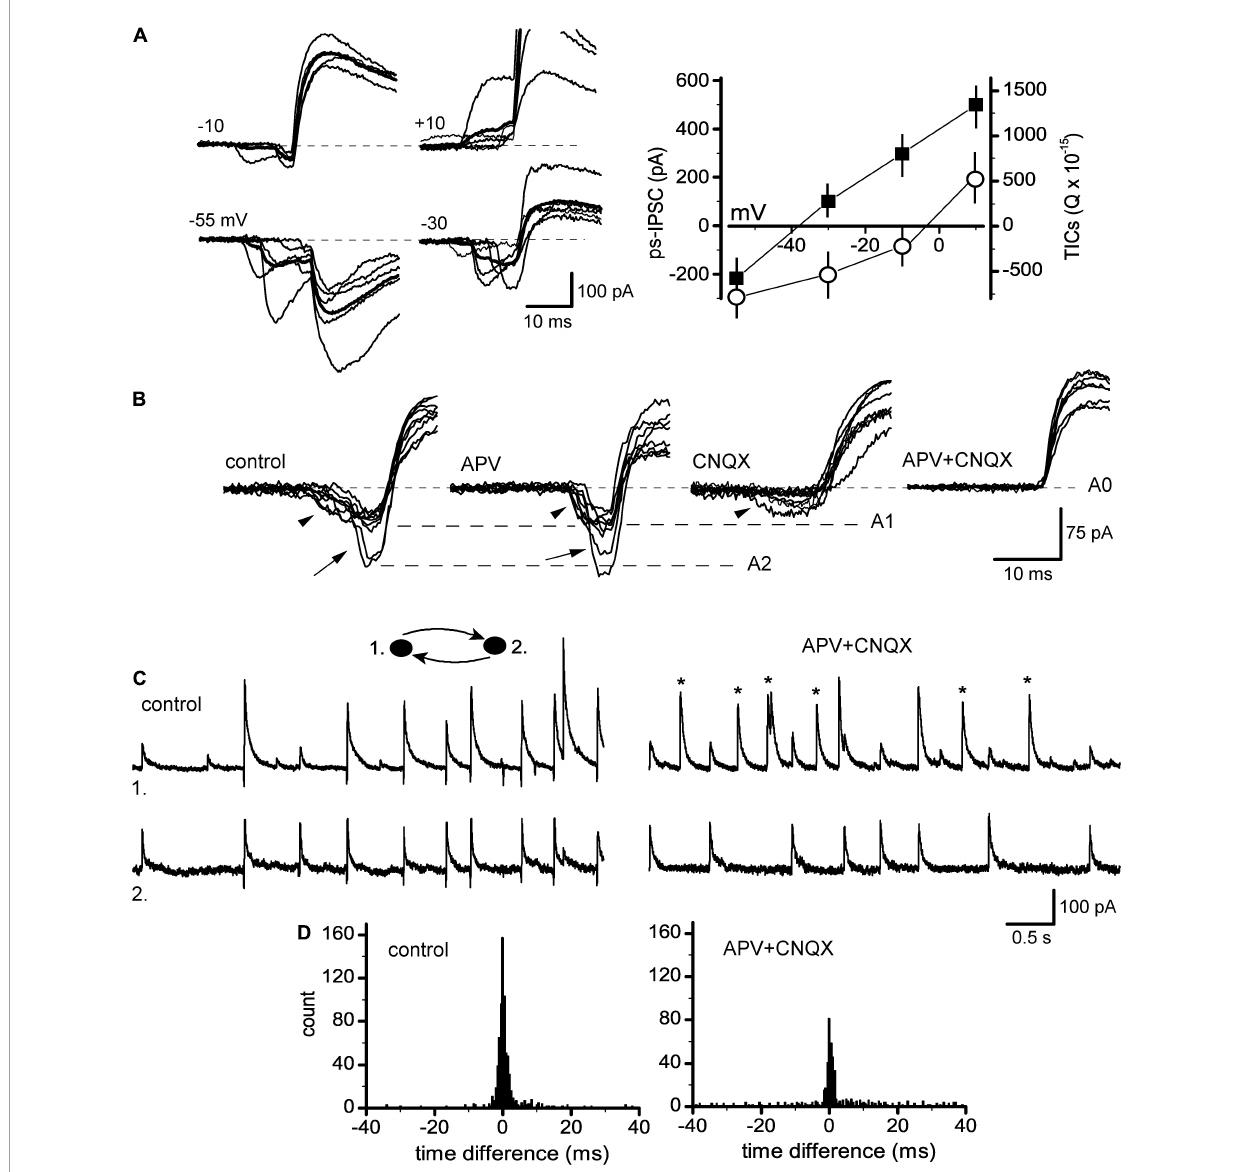
FIGURE5 Glutamate-dependent post-stimulus sIPSCs. (A) TICs/ps-IPSCs sequences at different membrane potentials ( left ), lines in thick show averages ( n = 10). Right , respective I-V curves plotted for both TICs (as integrals, open circles ) and ps-IPSCs (peak amplitudes, filled squares ). (B) Expanded and superimposed segments showing variety in TICs waveforms consisting of, respectively slow and small components ( arrowhead ) and fast transients ( arrow ), those fluctuated in an all-or-none way between levels A1 and A2 . Traces are shown in control, under APV, CNQX and in both. (C) Recording of ps-IPSCs in control ( left ) and under APV + CNQX ( right ), TICs were abolished and uncorrelated sIPSCs appeared ( stars ). (D) Respective time difference histograms.